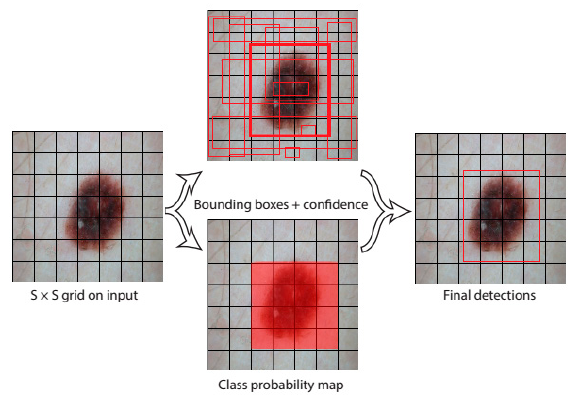
Figure 6. A simple representation of how You Only Look Once (Yolo) detects skin lesion location. Firstly, it divides the image into the ( S × S ) grids, each grid cell is responsible for creating B possible bounding boxes with their confidence score and C class probabilities.